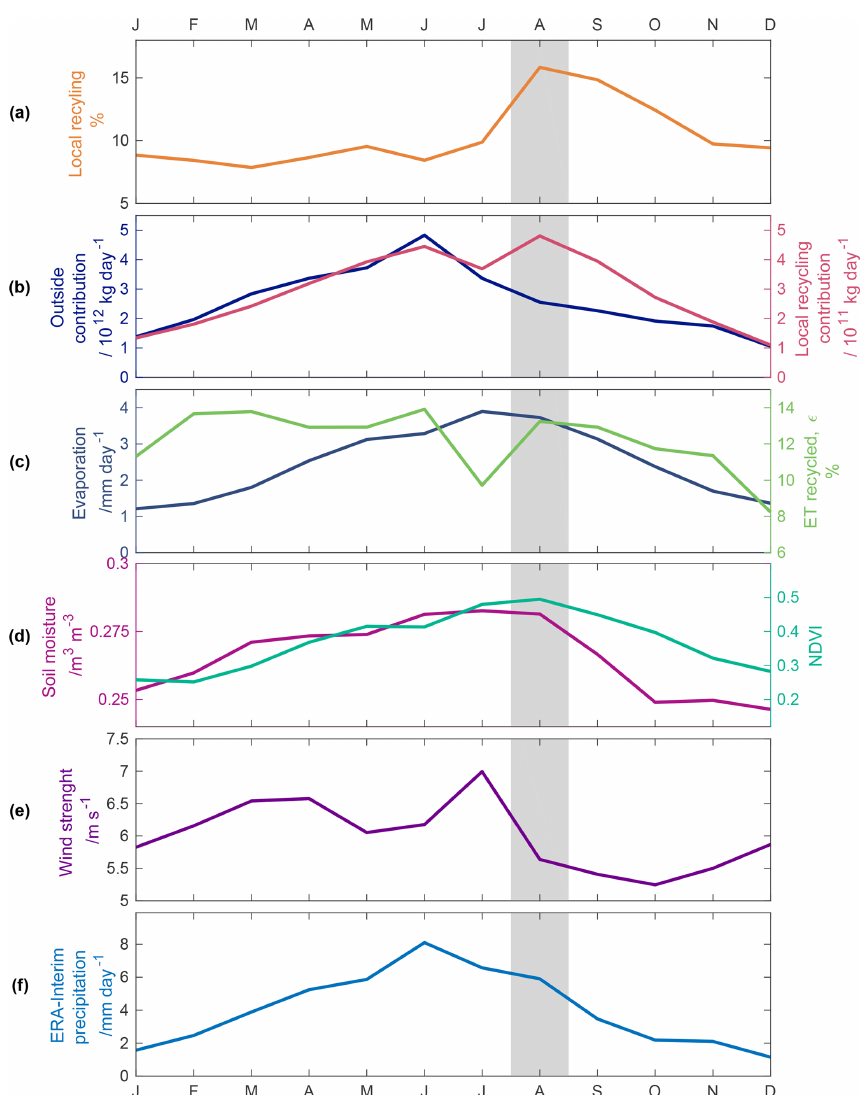
Figure 9. Seasonal cycle of YRV variables. The panels show (a) local recycling in percent; (b) absolute values of moisture contribution from regions outside YRV and within YRV in 10 12 and 10 11 kgd − 1 respectively; (c) ERA-Interim evapotranspiration over the YRV in millimeters per day (mmd − 1 ) and (cid:15) , the percentage of evapotranspiration over the YRV which is recycled; (d) ERA-Interim soil moisture in cubic meter water per cubic meter volume (m 3 m − 3 ) and NDVI (unitless); (e) ERA-Interim 850hPa wind strength over the region in meters per second (ms − 1 ); and (f) ERA-Interim precipitation in millimeters per day (mmd − 1 ). All values are monthly climatologies for 1980–2016 except NDVI, which is the 1982–2015 climatology. August is shaded, showing the month of the local recycling